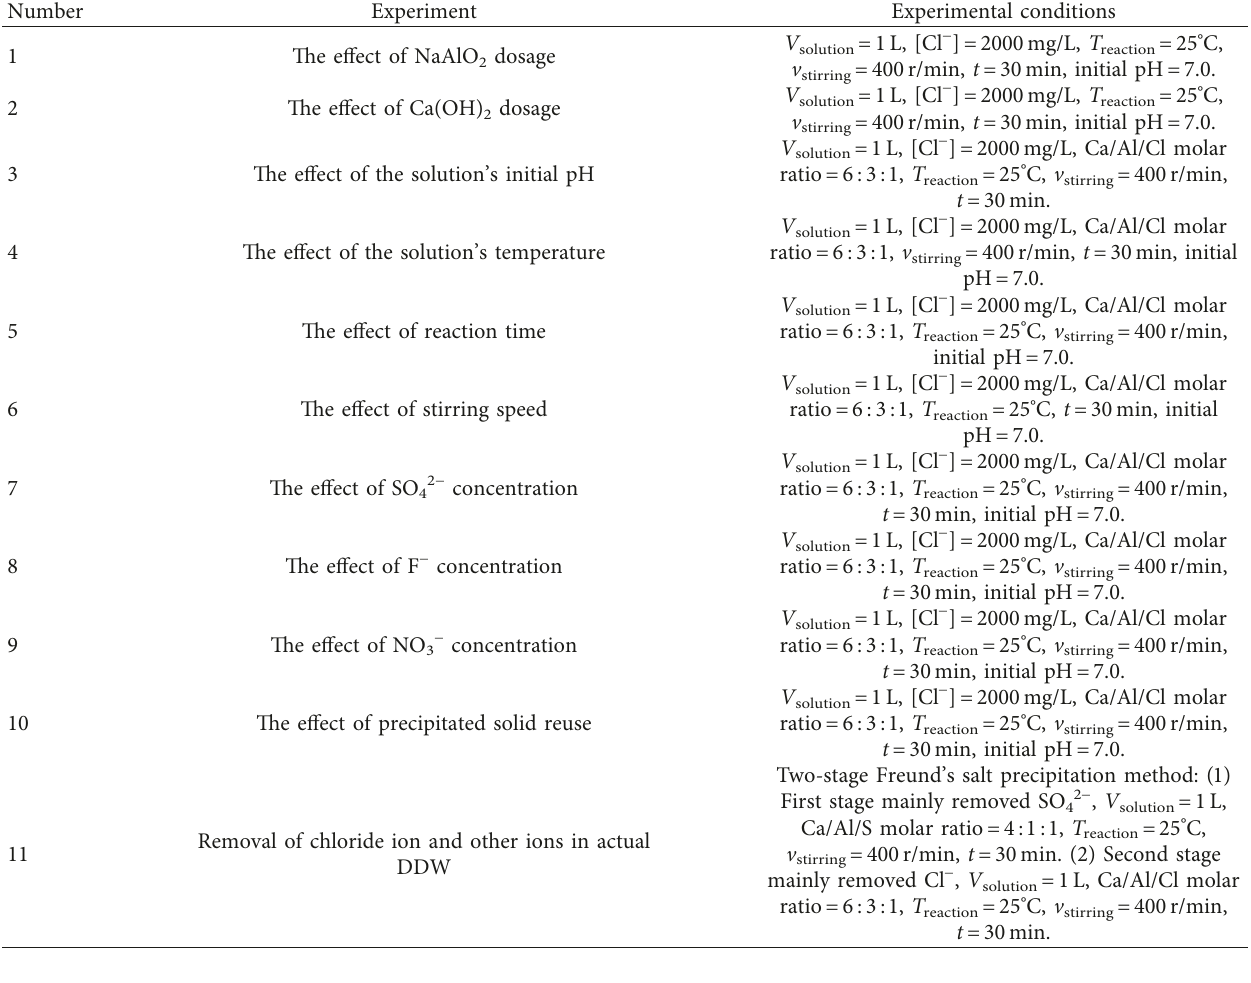
Table 1: Experimental conditions of the individual experiments.